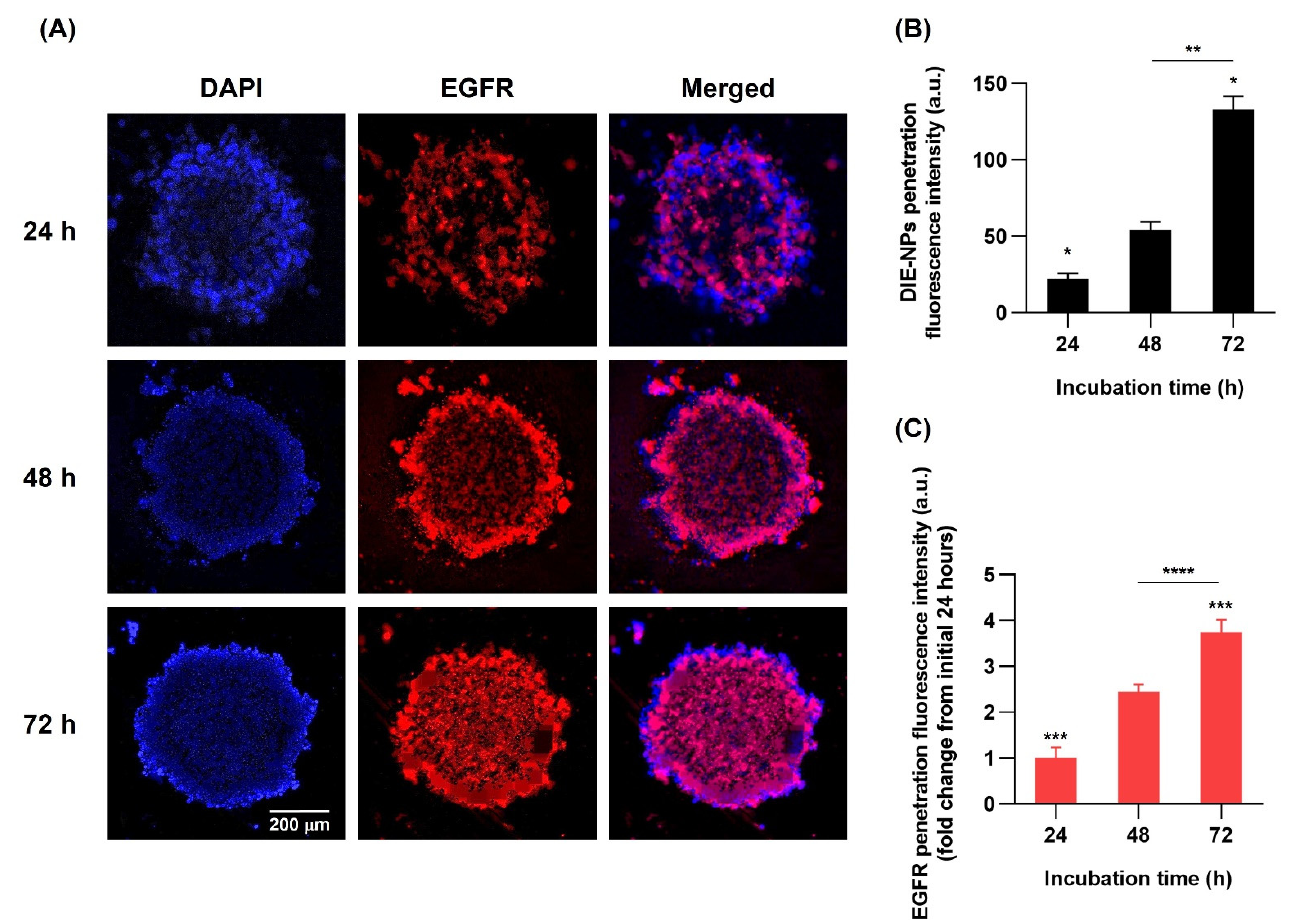
Figure 10. DIE-NPs penetration in a three-dimensional (3D) human MG-63 tumor spheroid. ( A ) Human MG-63 (EGFR+) spheroids fluorescence images treated with Alexa Fluor 647 anti-human EGFR antibody conjugated to the surface of the DIE-NPs (red channel), and MG-63 cell nucleus DAPI stained (blue channel) from initial 24 h at incubation times 24, 48 and 72 h. Scale bar = 200 µ m. ( B ) Quantification of DIE-NPs penetration fluorescence intensity of Alexa Fluor 647 anti-human EGFR antibody conjugated to the surface of the DIE-NPs (red channel) from initial 24 h at incubation times 24, 48 and 72 h. * denotes significance in DIE-NPs penetration fluorescence intensity of Alexa Fluor 647 anti-human EGFR antibody conjugated to the surface of the DIE-NPs between initial 24 h and 72 h incubation times ( p < 0.05). ** denotes significance in DIE-NPs penetration fluorescence intensity of Alexa Fluor 647 anti-human EGFR antibody conjugated to the surface of the